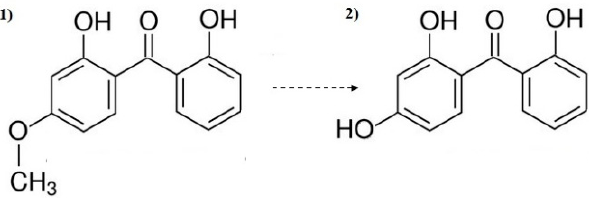
Figure 9. Identified 1 dioxybenzone by-product, where 2 is 2,2 ′ ,4-trihydroxybenzophenone.